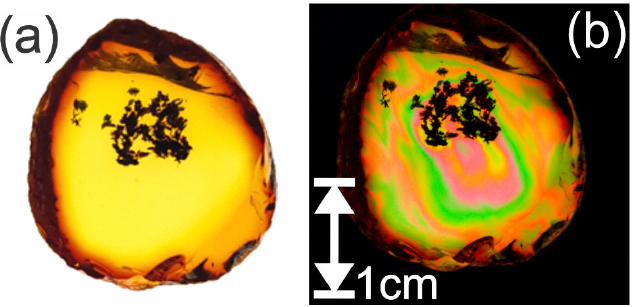
Figure 5. Visible polarization images due to internal stresses. Visual polarization images of Mexican Chiapas amber. ( a ) Using a vertically linear polarized light source behind the amber. ( b ) Using a linear polarized lens perpendicular (crossed) to the polarized light source.